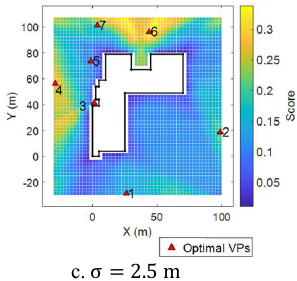
Figure 3. Solutions for Example 2: WGA is applied to get solutions under three